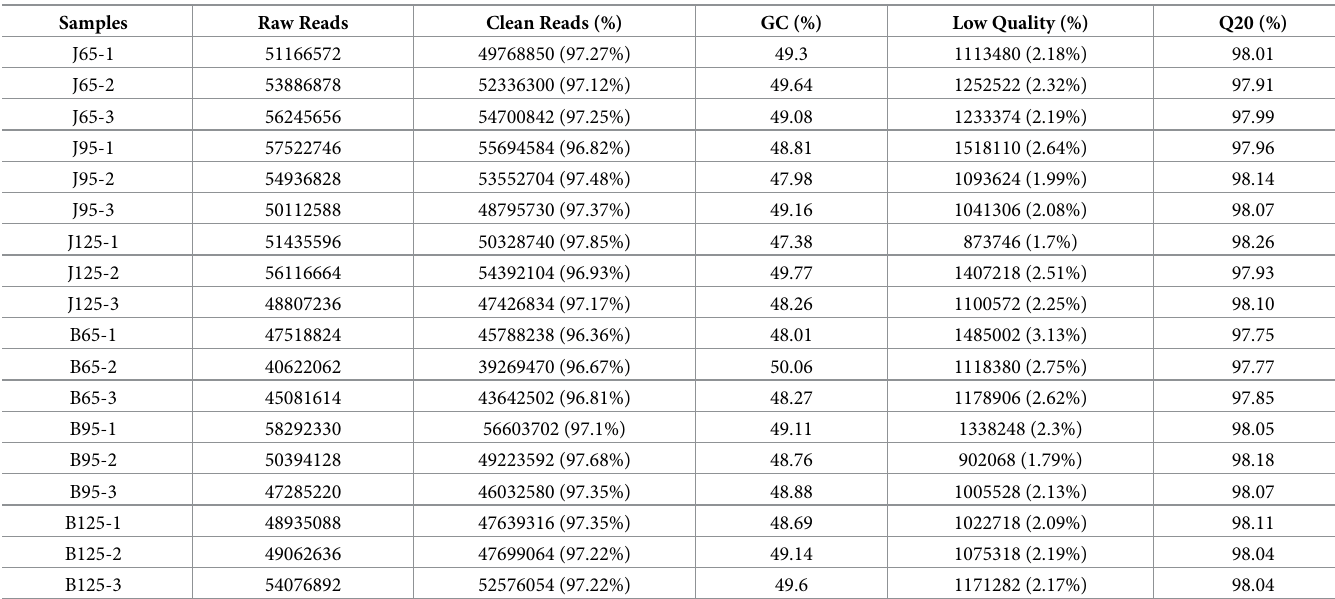
Table 1. Summary of the sequencing data analyses. Samples